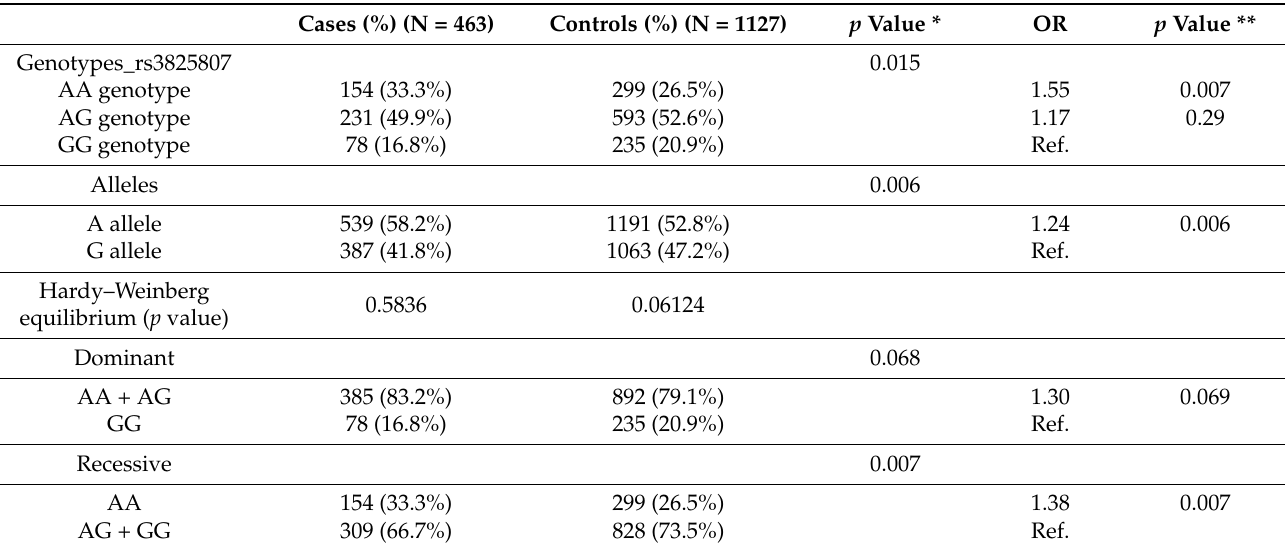
Table 2. Distribution of rs3825807 polymorphism genotypes, alleles, dominant, and